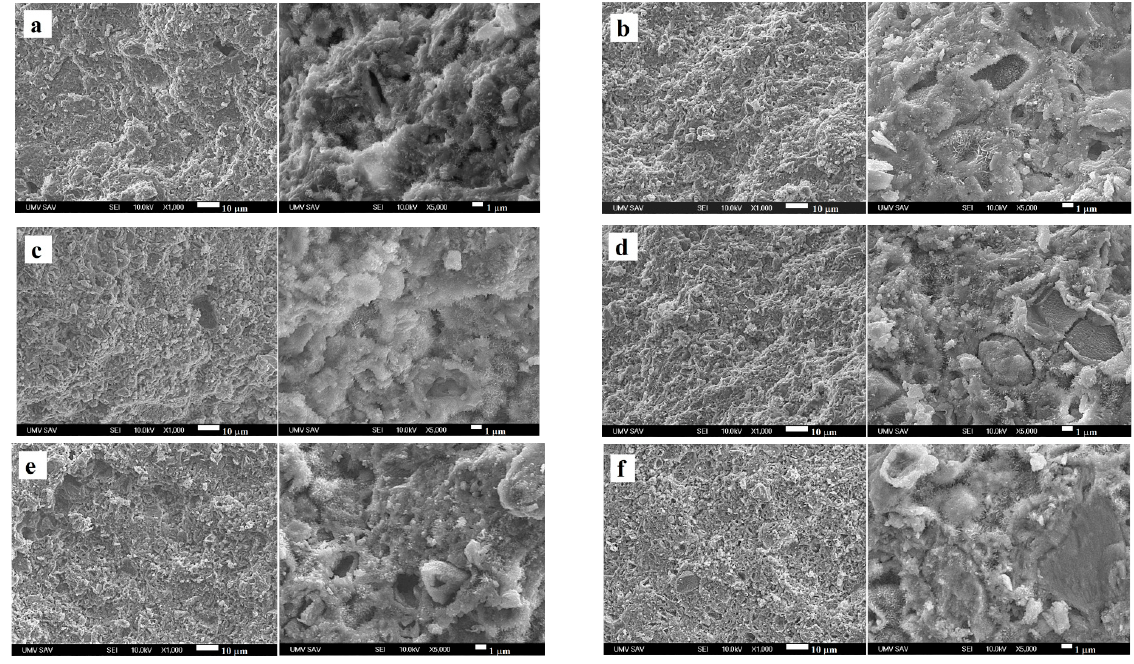
Figure 3. Microstructure of fractured cements after 7 days of hardening in SBF at 37 °C: CT ( a ), CT1Si ( b ), CT2Si ( c ), CT5MP ( d ), CT5MP1Si ( e ), CT5MP2Si ( f ).